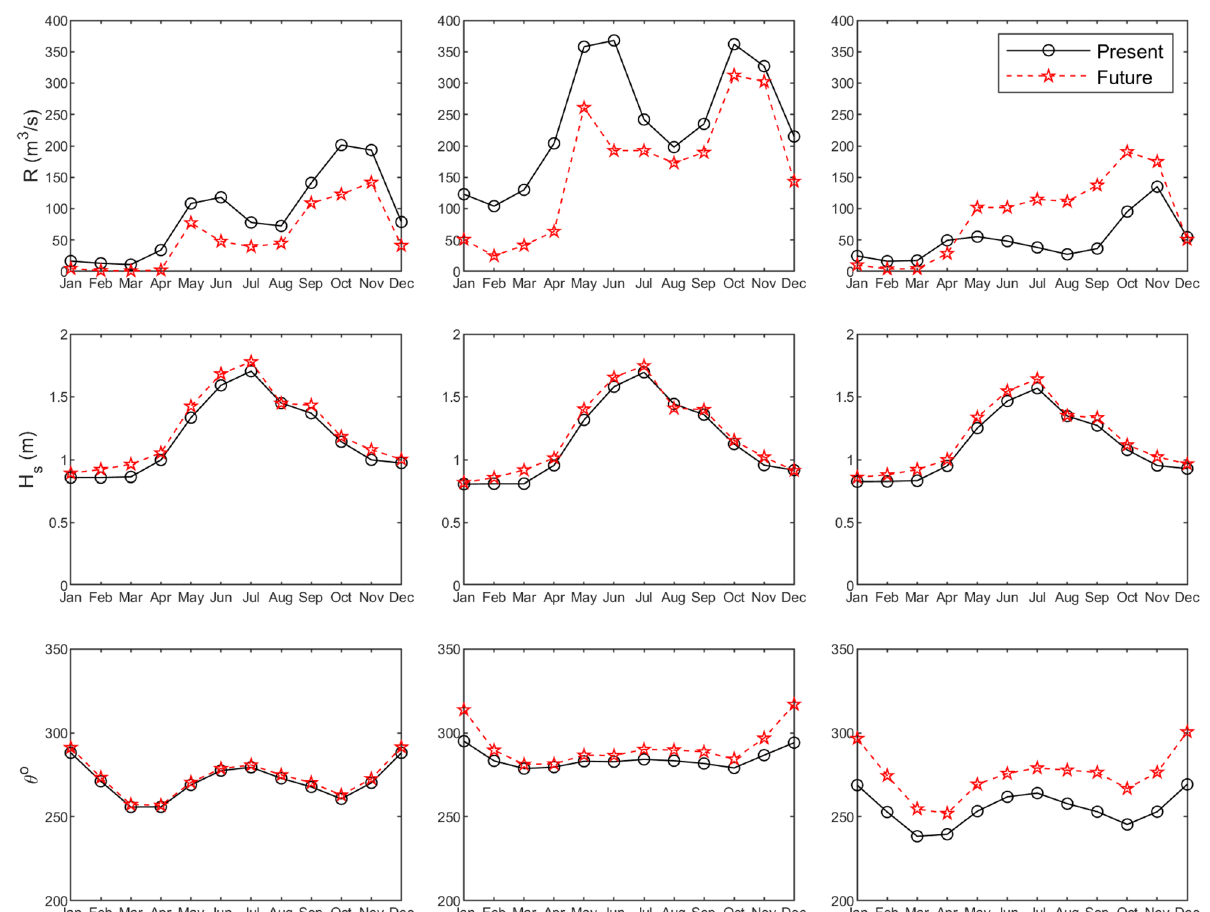
Figure 4. Contemporary and projected end-century forcing time series for Negombo lagoon (left), Kalutara lagoon (middle), and Maha Oya river (right); Top: riverflow ( R ), Middle: Significant wave height ( H s ) at 10 m depth, Bottom: Mean wave direction ( θ ) at 10 m